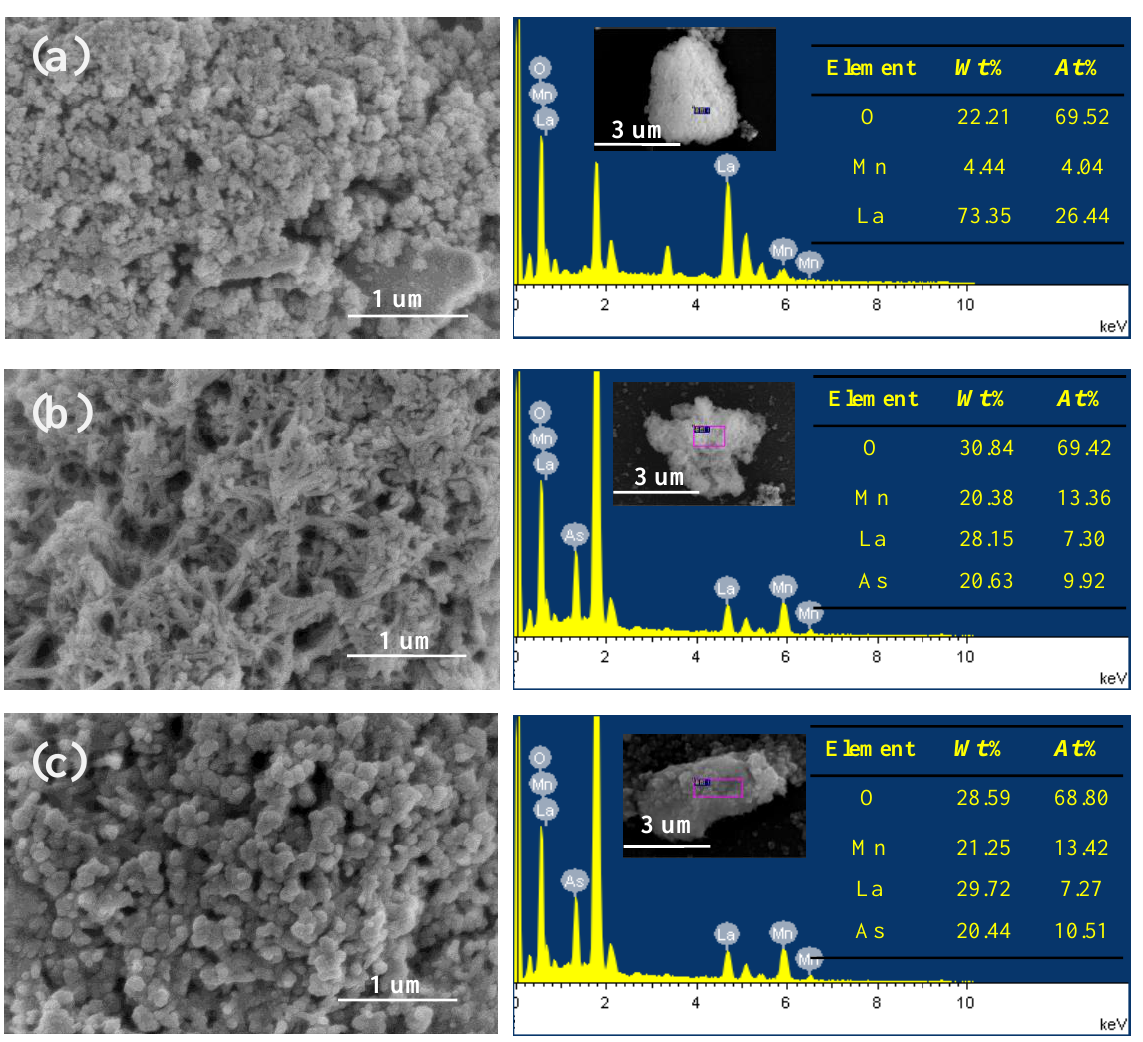
Figure 2. SEM micrographs and EDS analyses of core – shell structured MnO 2 @La(OH) 3 nanocomposite before ( a ) and after the uptake of As(V) ( b ) and As(III) ( c ).